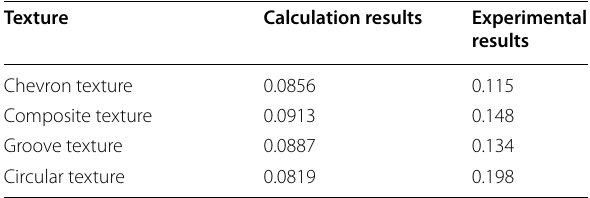
Table 5 Calculation results of